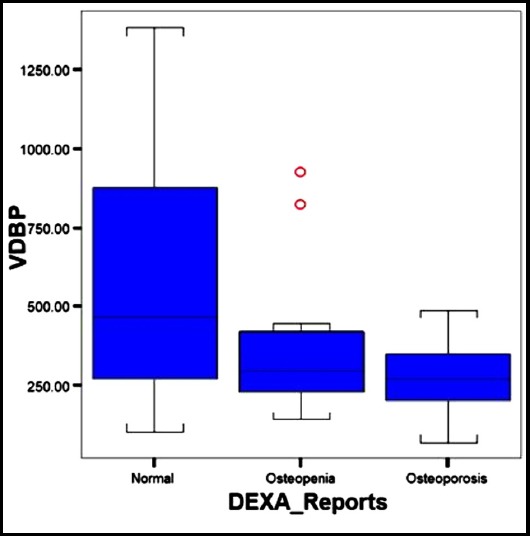
Comparison of Vitamin D Binding Proteins in the Study Groups.